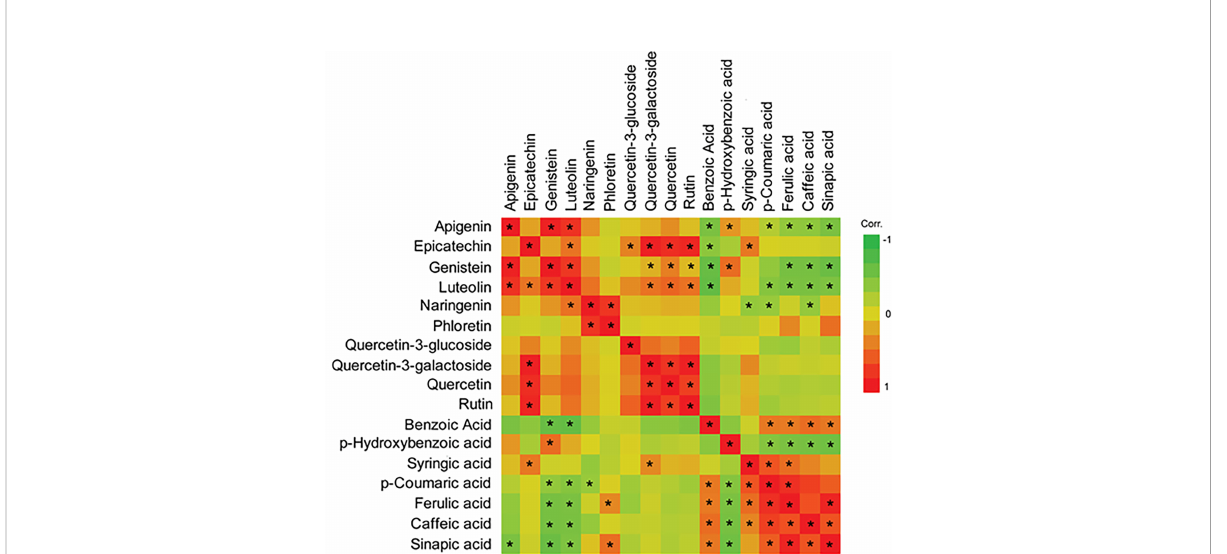
FIGURE 6 Correlation plot of phenolics and fl avonoid compounds differentially changed after 10 days of fall armyworm (FAW) infestation on sorghum plants. A Pearson pairwise correlation was calculated for differentially induced phenolic and fl avonoid compounds in JMP Pro 14. Asterisks are used to show signi fi cant correlations between compounds ( P <